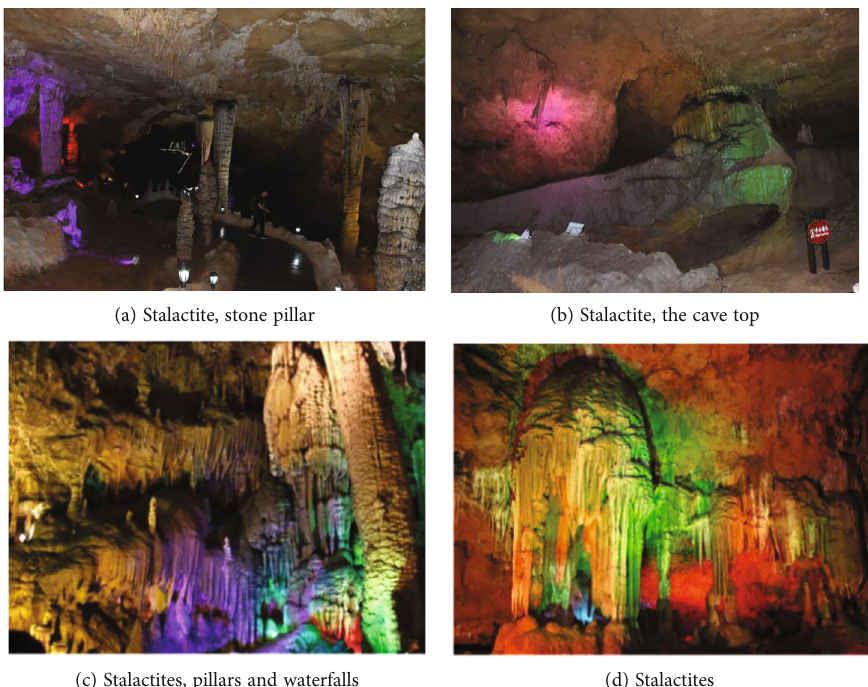
Figure 7: Karst morphological types and characteristics in Longwang cave.